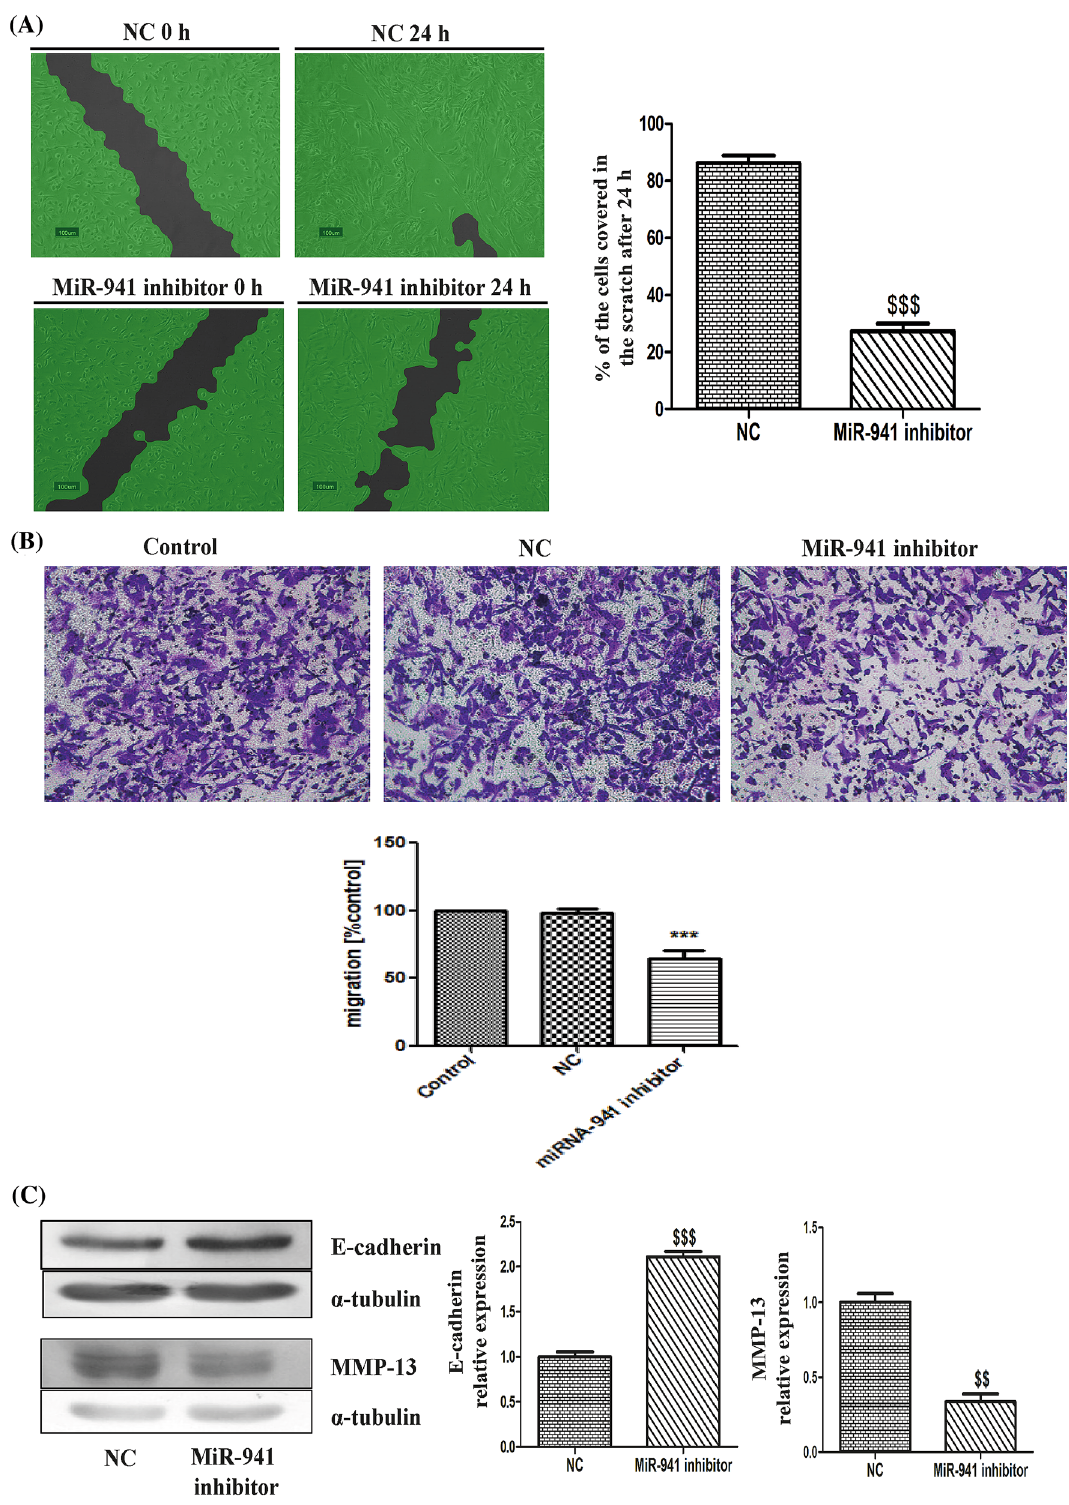
Figure 3. MicroRNA-941 inhibitor impeded the migration and invasion of MDA-MB-231 cells. ( A ) Scratch wound images and WimScratch tool quantitative analysis of percentage of the cells covered in the scratch after 24 h transfection with miRNA-941 inhibitor (50 nM) in comparison to negative control. ( B ) Transwell migration assay with miR-941 inhibitor in MDA-MB-231 cells. ( C ) Western blotting and densitometric analysis of E-cadherin and MMP-13 in MiR-941 inhibitor (50 nM) transfected MDA-MB-231 cells for 24 h. α-tubulin was used as loading control for our experiment. Results shown were representative of three different experiments. All values were expressed as mean ± S.E.M. $$ p < 0.01, $$$ p < 0.001 significant vs negative control